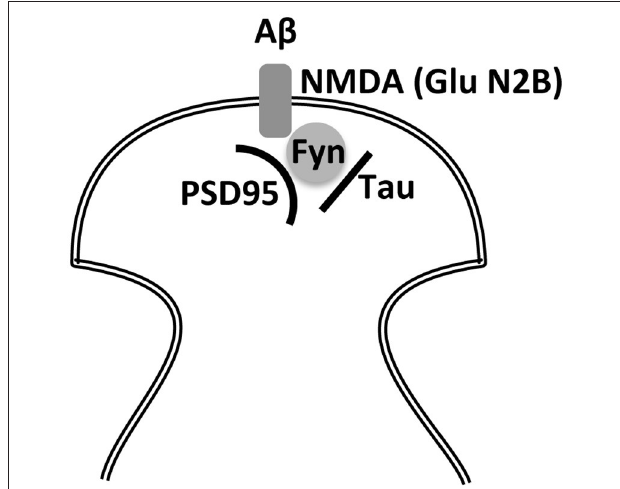
FIGURE 3 | Indirect interaction between A β and tau through the NMDA receptor and fyn kinase. Two of the main molecular markers involved in Alzheimer disease, A β and tau, may require for their toxic effects of NMDAR-PSD-95 playing a role the kinase Fyn to alter post-synaptic